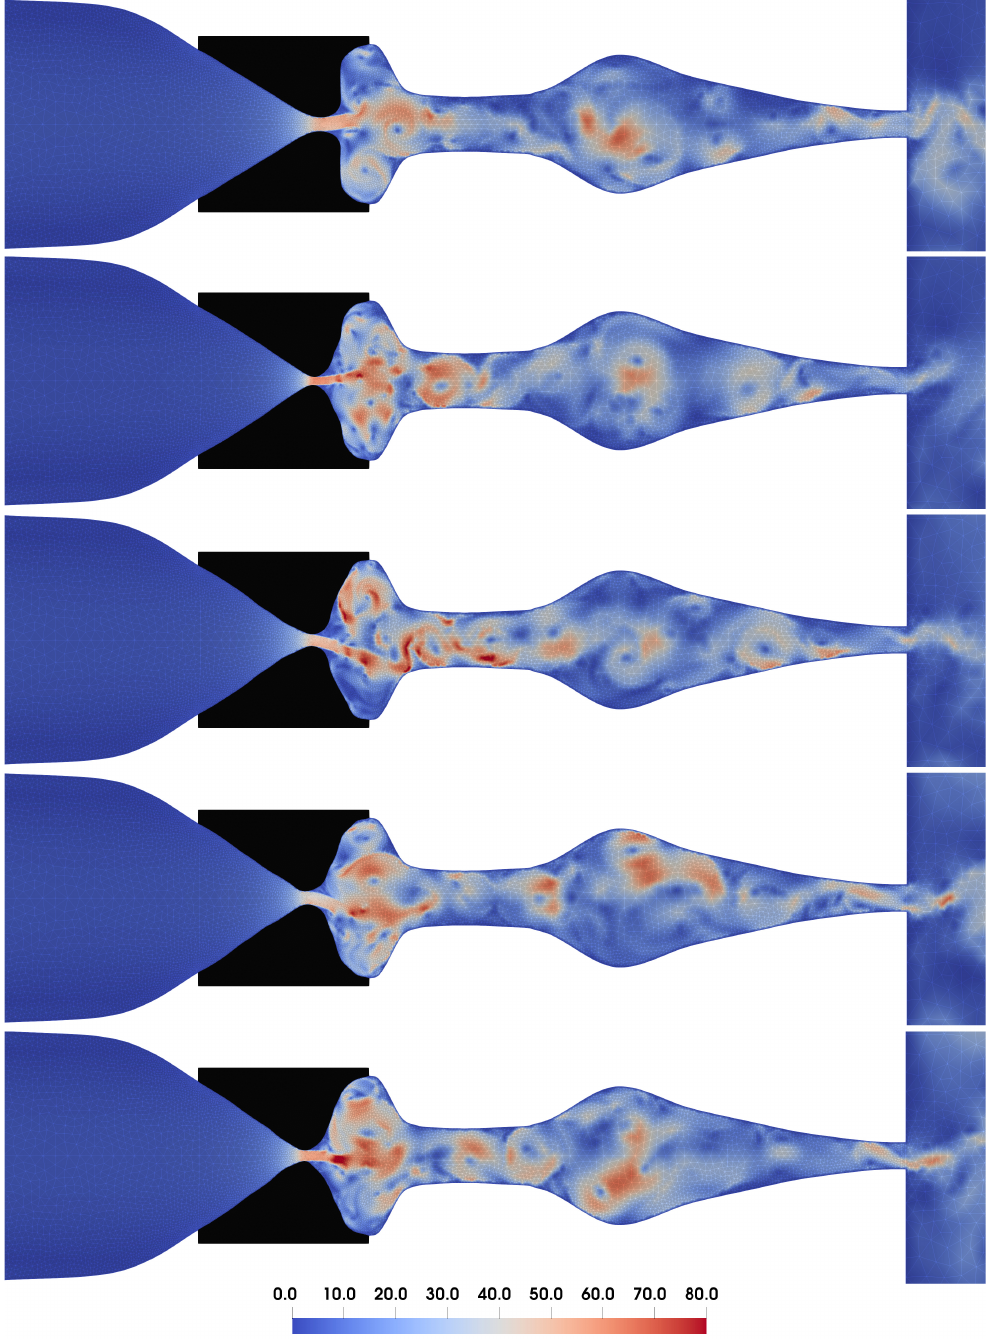
Figure 5. Velocity field in the glottal region at five time instants ( t = 0.0074,0.0084,0.0094, 0.0104,0.0114s) of the vocal folds